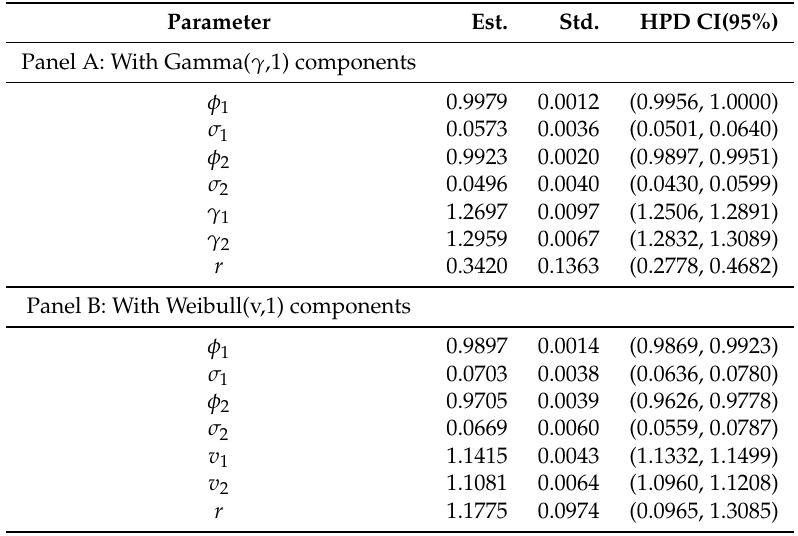
Table 3. Parameter estimates based on TSCD models based on the Boeing transaction data.